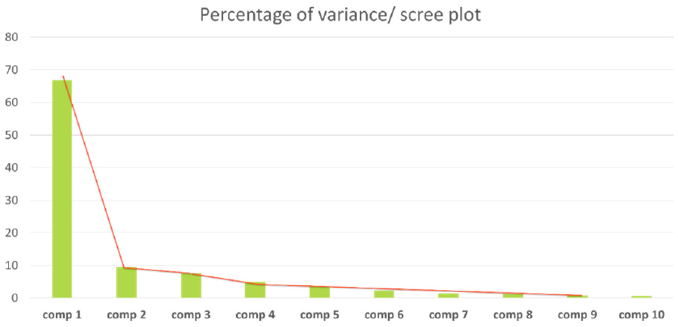
Figure 7. Scree plot. Table 2. Eigenvalues of the 4 first